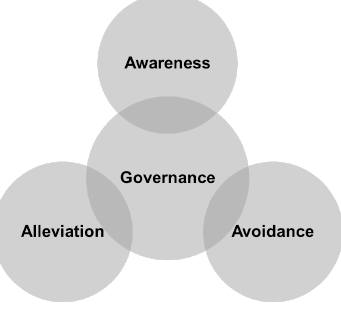
Figure 1. 3As&G evaluation framework adopted in